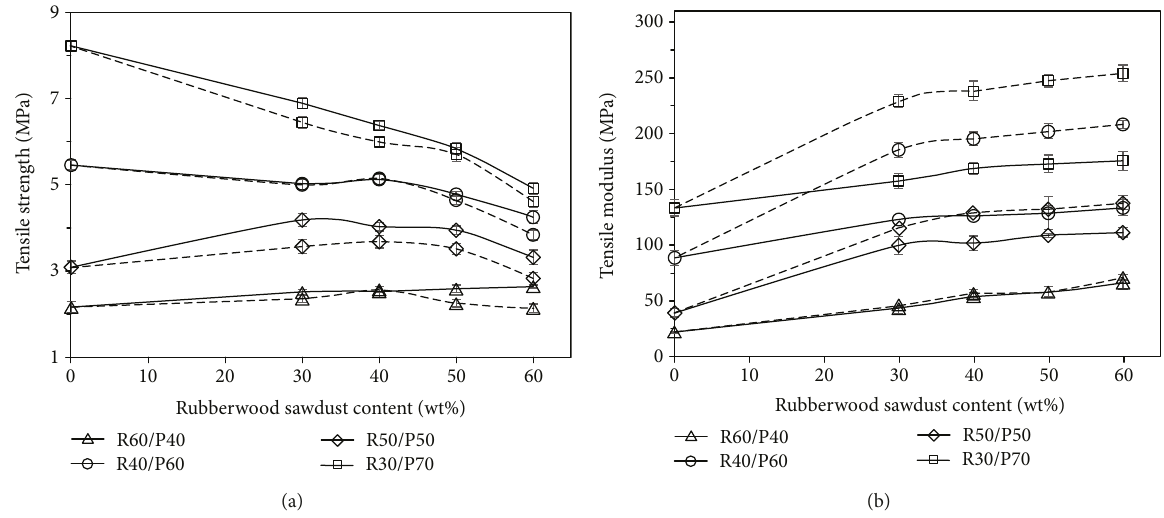
Figure 6: E ff ect of wood sawdust contents and sizes on (a) tensile strength and (b) tensile modulus for TPNR/RWS composites. Dashed lines show RWS 40 mesh, and solid lines represent RWS 80